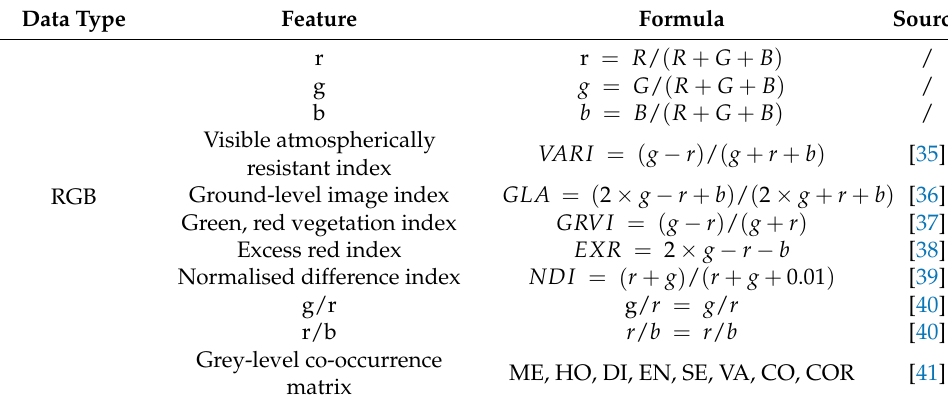
Table 2. Spectral and textural features of the RGB sensor.